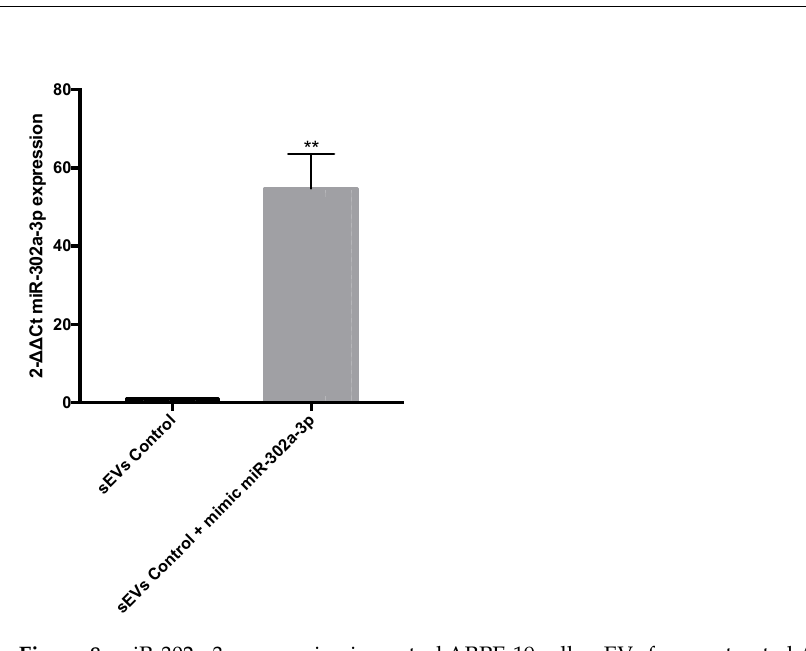
Figure 8. miR-302a-3p expression in control ARPE-19 cells. sEVs from untreated ARPE-19 cells (1 ± 0) and sEVs from miR-302a-3p mimic transfected ARPE-19 cells (54.8 ± 8.71). Values are expressed as mean ± SEM ( n = 3). The p -value was calculated by t-test, and statistically significant differences were ** p < 0.01.